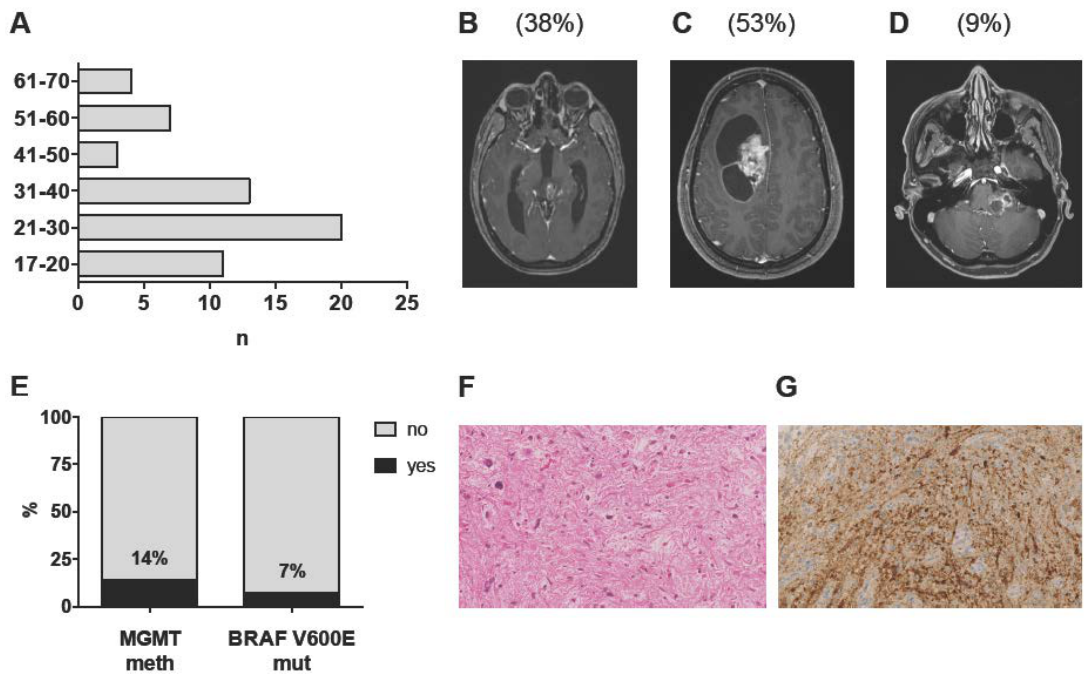
Figure 1. Clinico-pathological characteristics of the complete cohort (n = 58): ( A ) Age distribution at 1st diagnosis in decimal steps. ( B – D ) Representative T1 post-contrast MR images of tumors of the midline ( B ), the cerebral / cerebellar hemispheres ( C ) and the cerebello-pontine angle ( D ). Percentages of the respective tumor locations are given in brackets. ( E ) Distribution of MGMT promoter methylation (n = 57 patients) and BRAF V600 mutation status (n = 30 patients). ( F ) Representative hematoxylin / eosin-stained section of a PA WHO grade I (MGMT meth). ( G ) BRAF V600E staining employing a mutation-specific antibody (BRAF V600E positive cells stained in brown). Stainings are displayed in 400-fold magnification. Table 1. Patient characteristics of the complete cohort (n = 58); stratified for MGMT promoter methylation status.